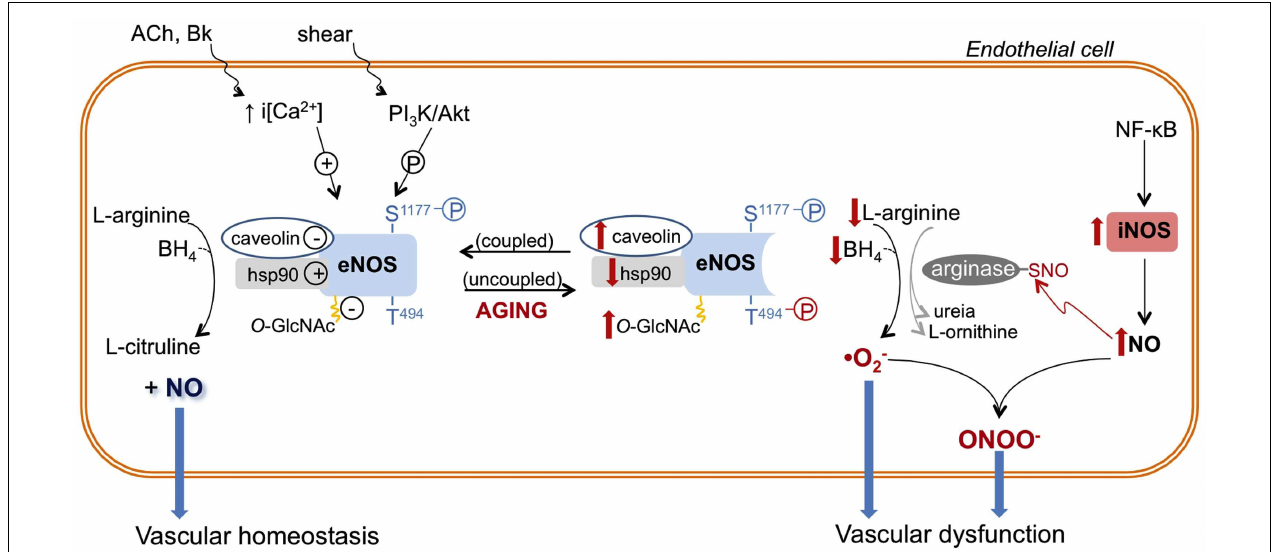
increased phosphorylation ofT 494 . In addition, reduced availability of l-arginine and tetrahydrobiopterin (BH 4 ) induces eNOS uncoupling or changes the ) generation. In aged enzyme to a state that favors superoxide anion ( • O − 2 endothelial cells, up-regulated iNOS, which may be associated with NF- κ B-induced vascular inflammation, produces high levels of NO. NO reacts with cysteine residues of proteins (arginase in this example), forming S -nitrosothiol (-SNO)–arginase, which increases arginase activity and l-arginine consumption. NO directly reacts with • O − produced by uncoupled 2 eNOS, and other vascular sources, generating the harmful reactive nitrogen specie peroxynitrite (ONOO − ), which contributes to vascular dysfunction.The aging–associated NOS alterations are depicted in red. ACh, acetylcholine; Bk, bradykinin; PI 3 K,